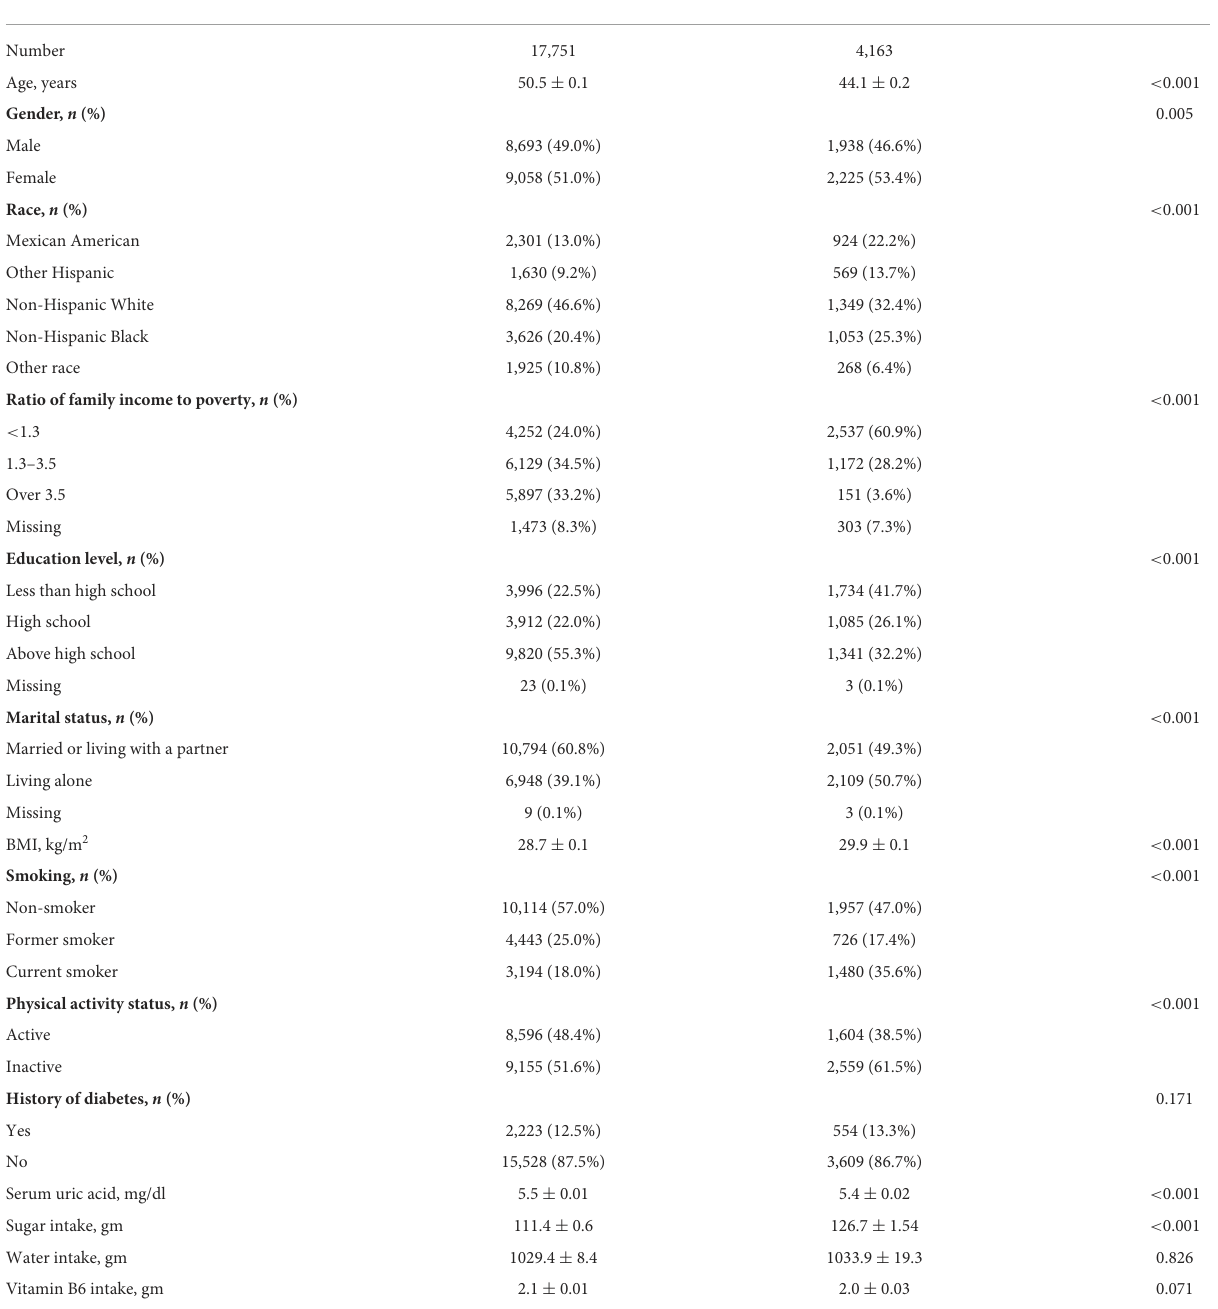
BMI,bodymassindex. Thevaluesarepresentedasweightedmeans ± SEorunweightedcounts(weighted%).